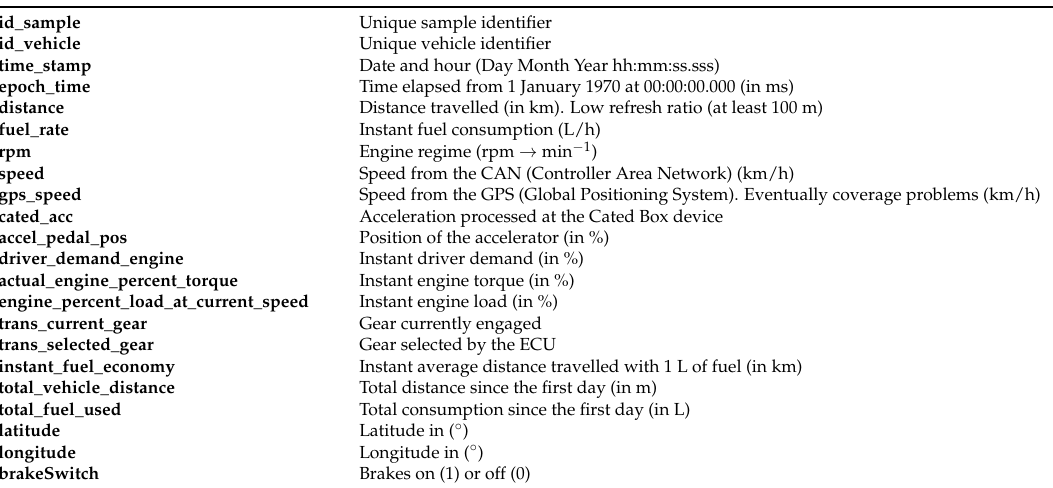
Table 1. Parameters obtained from the vehicle.